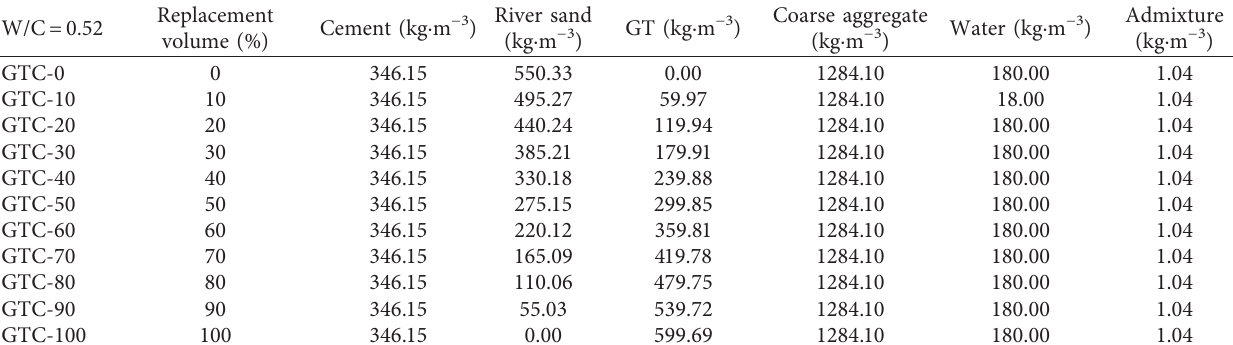
Table 5: Mixing proportions of GTC 0% to 100% (kg/m 3